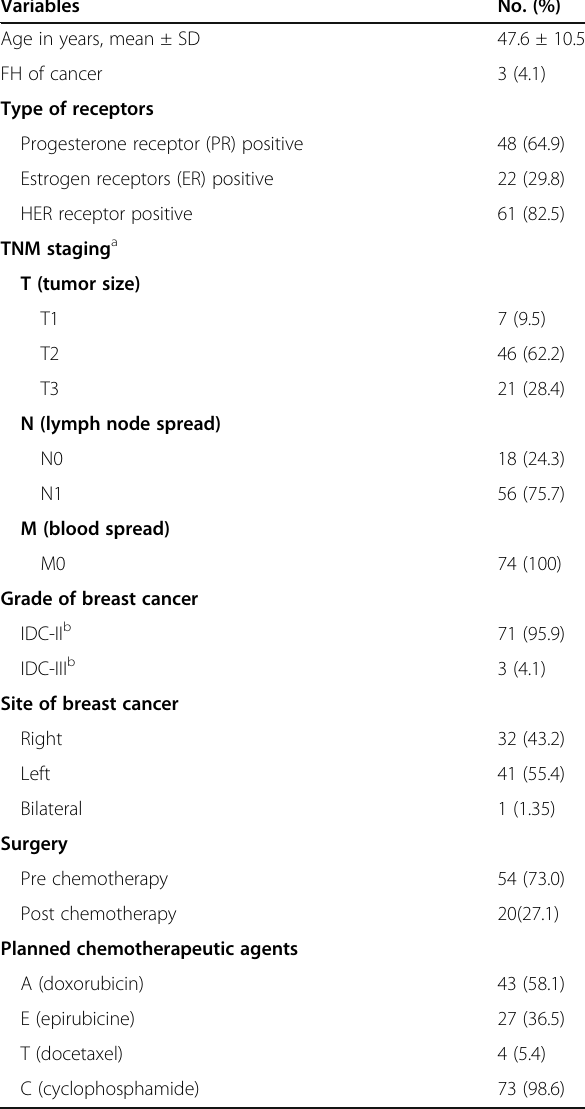
Table 1 Baseline (first visit) clinical characteristics of the patients